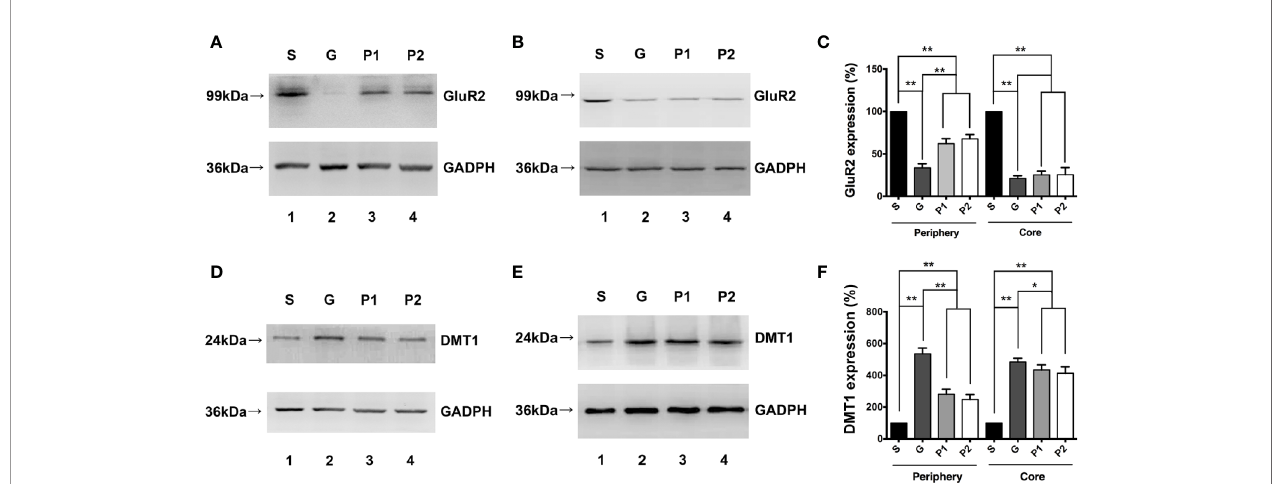
FIGURE 2 | Effects of propofol infusion on GluR2 and DMT1 in two areas 18 days after glioma model establishment. (A) Western blotting result showed expression of GluR2 in the 2-mm diameter periphery of the gliomas. (B) Expression of GluR2 in the core of the gliomas. (C) Quanti fi cation of GluR2 expression and comparison within periphery and core groups. (D) DMT1 expression in the 2-mm diameter periphery of gliomas. (E) DMT1 expression in the core of the gliomas. (F) Quanti fi cation of DMT1 expression and comparison within the periphery and core groups. Data are presented as the mean ± SD (n=6/group). *P < 0.05 and **P < 0.01. Groups: S, sham; G, glioma; P1 and P2, propofol 20, and 40 mg/kg -1 /h -1 , respectively. DMT1, divalent metal transporter